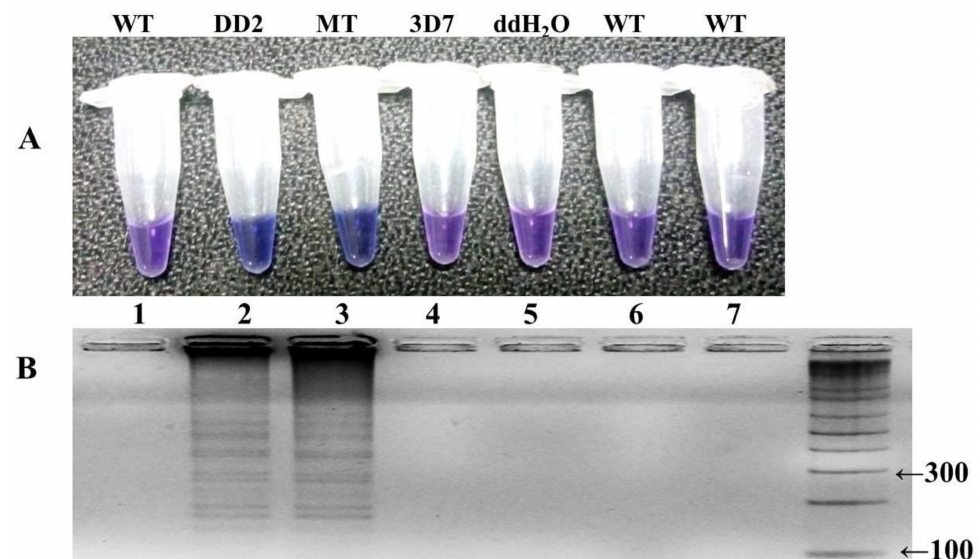
Figure 3. HNB–LAMP assay detection of the S108N mutation with the primer set FIPM1 in pyrimethamine (PYR)-resistant samples of P. falciparum and the assessment of LAMP products on gel electrophoresis. ( A ) PYR-resistant mutant strains of P. falciparum are indicated by the blue color shown in tube no. 3, including positive control in tube no. 2, while, the negative shows a violet color in tubes no. 1, 6, and 7, including negative control 3D7 (tube no. 4). ( B ) Taxation was based on